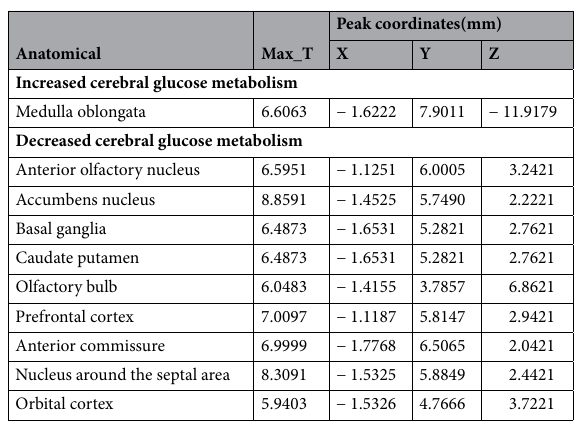
Table 4. Changes in brain glucose metabolism in the Sham-MA group versus the SHR group.